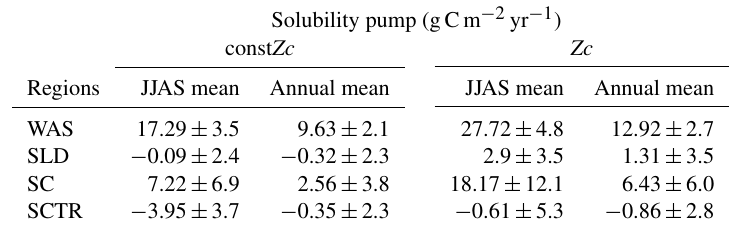
Table 6. Same as Table 5, but for solubility